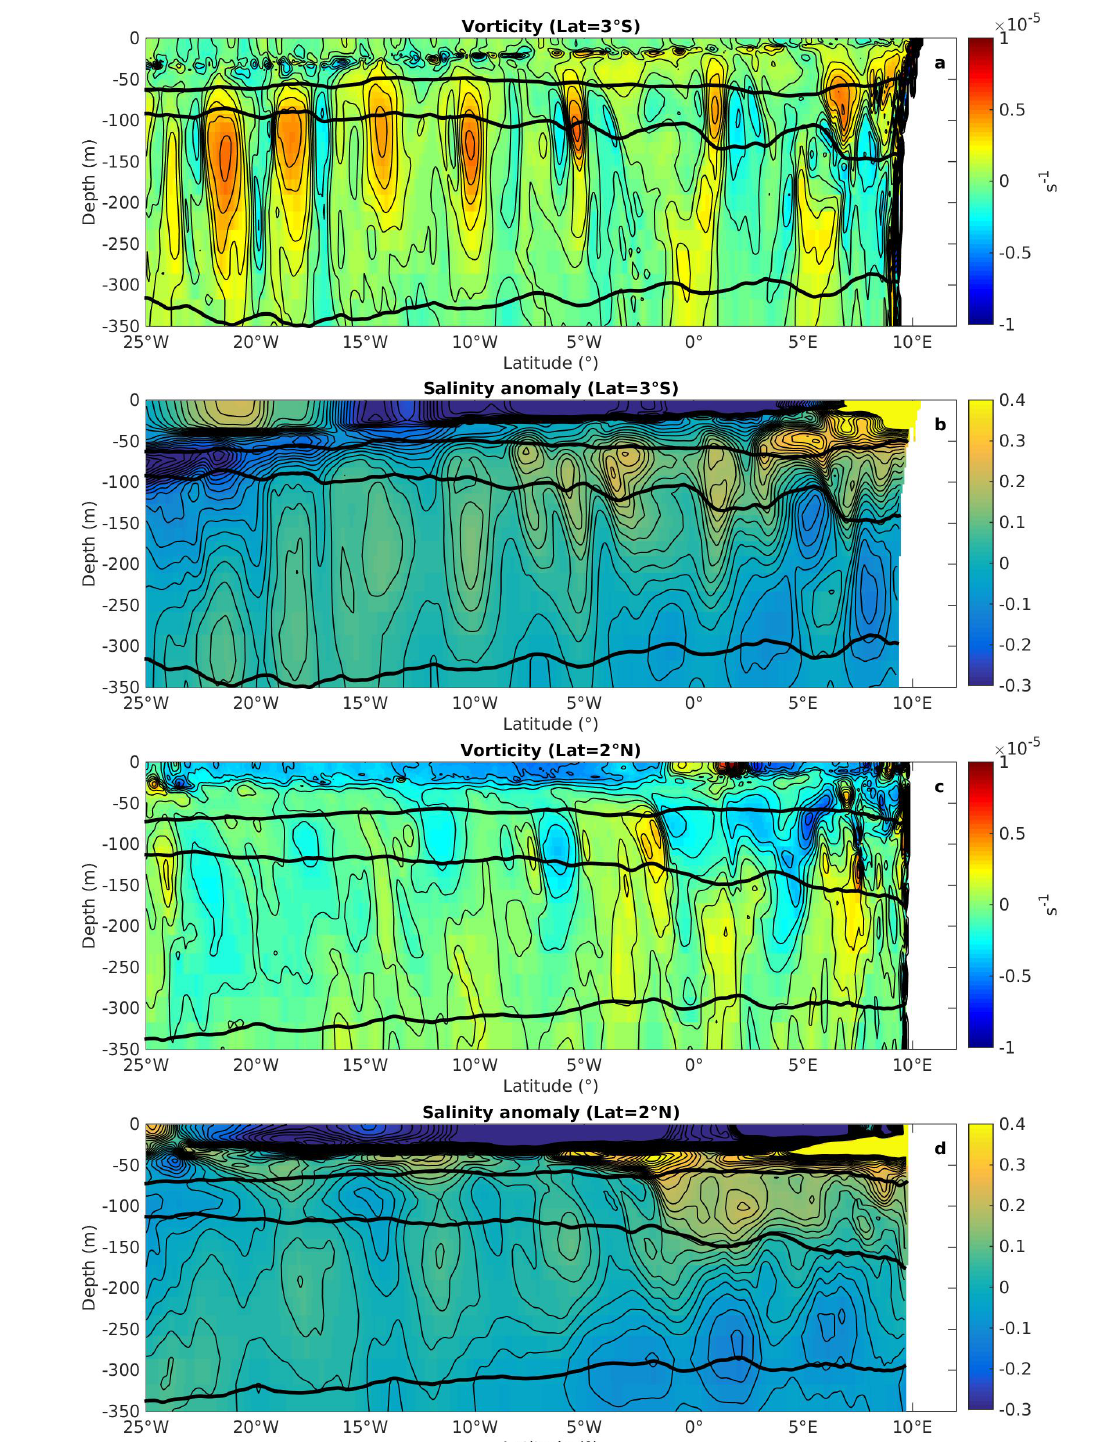
Figure 11. Zonal sections of vorticity and salinity along 3 ◦ S ( a , b ) and 2 ◦ N ( c , d ) on 10 May. Thick black lines represents the isopycnic levels defining layers 1 and